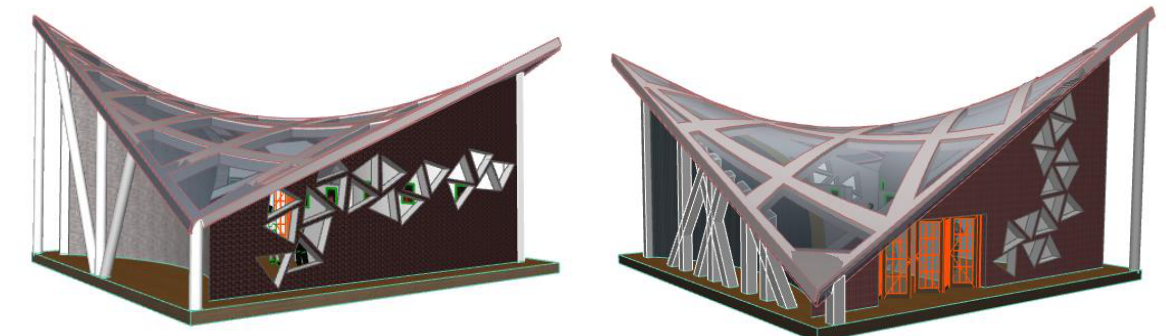
Figure 2. Details added within the project (Openings, structure and roof